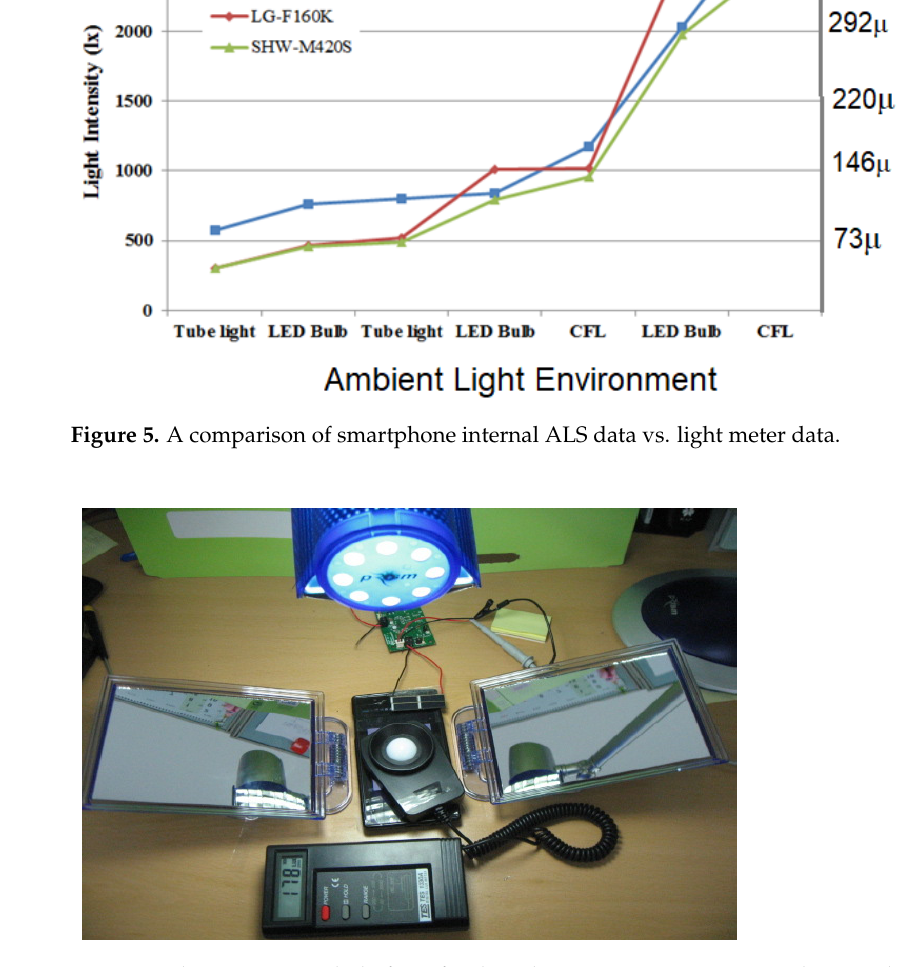
Figure 6. The experimental platform for the solar concentrator system with an angled ( θ ) setup.